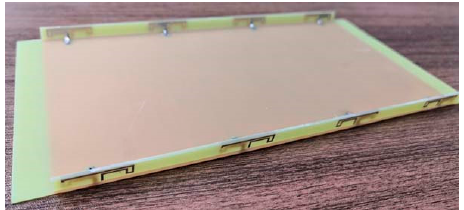
Figure 9. Photograph of the fabricated MIMO antenna array.